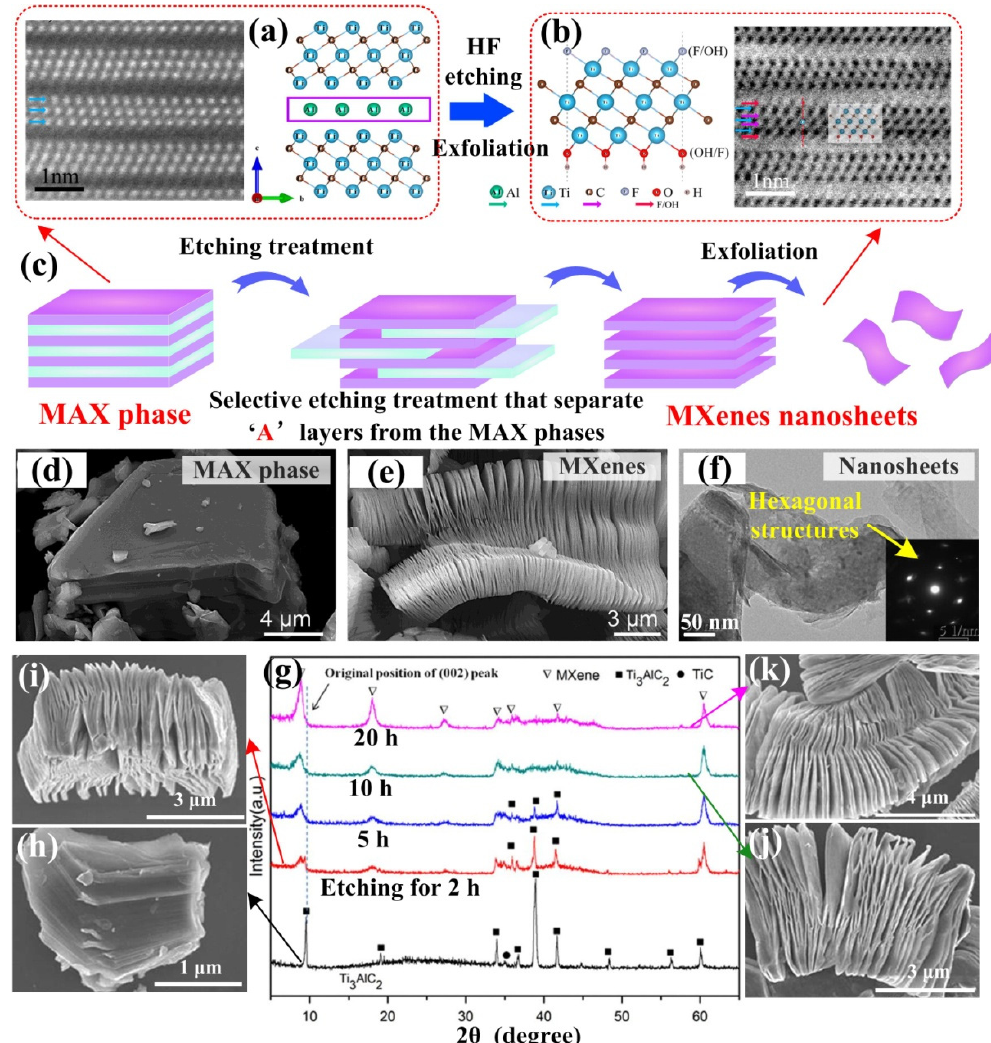
Figure 7. ( a ) The atomic structure of the Ti 3 AlC 2 MAX phase and a high-angle annular dark-field (HAADF) image of multilayer Ti 3 C 2 T x (here the image only shows the inheritance of Ti 3 C 2 T x from the parent Ti 3 AlC 2 , so we use this image to represent the MAX phases arrangement, and the inherited Ti 3 C 2 T x can be seen as a Ti(s)-C-Ti(c)-C-Ti(s) arrangement). The final Ti 3 C 2 T x monolayers in ( b ) show that on both sides of the Ti 3 C 2 layer, the functional groups (-O and/or -F) atoms favor staying on top of the Ti(c) atoms rather than at the topmost sites of the C atoms, with permission from Reference [64], Copyright (2015) American Chemical Society. ( c ) The schematic diagram of the etching treatment and exfoliation process to remove the ‘A’ layer from the MAX phase to obtain MXenes. ( d – f ) The actual morphology evolutions from the MAX phase to MXenes, and to nanosheets by exfoliation, with permission from Reference [12], copyright (2012) American Chemical Society. With permission from Reference [62], copyright (2015) Elsevier. ( g ) The X-Ray Diffraction (XRD) analysis of Ti 3 AlC 2 before and after HF treatment for 2 h, 10 h, and 20 h. ( h – k ) are the corresponding SEM